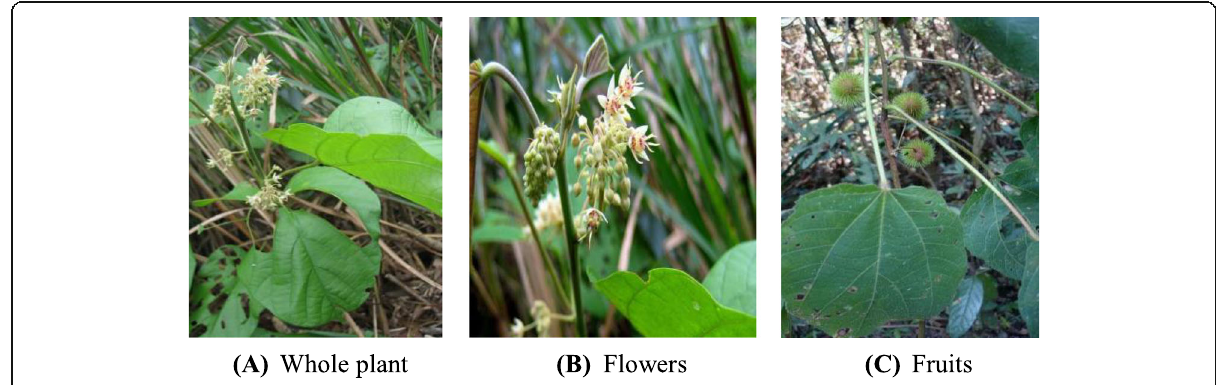
Fig. 1 Morphological structure of Byttneria pilosa Roxb . A Whole plant, B Flowers, C